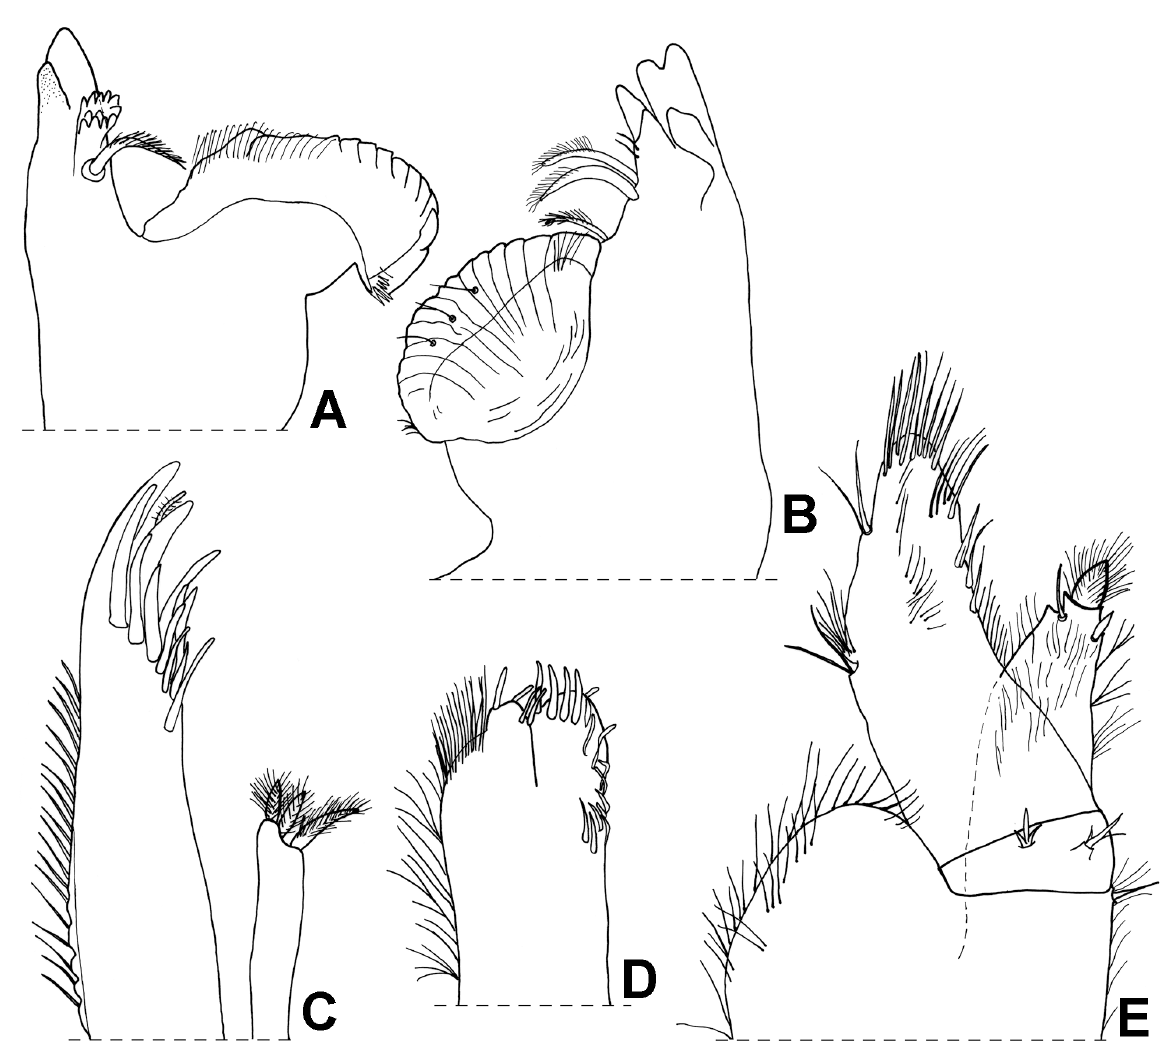
Fig. 14. Troglonethes olissipoensis Reboleira & Taiti sp. nov. from Gruta de Alvide, Lisbon Peninsula, paratype, ♂. A . Right mandible. B . Left mandible. C . Maxillula. D . Maxilla. E .